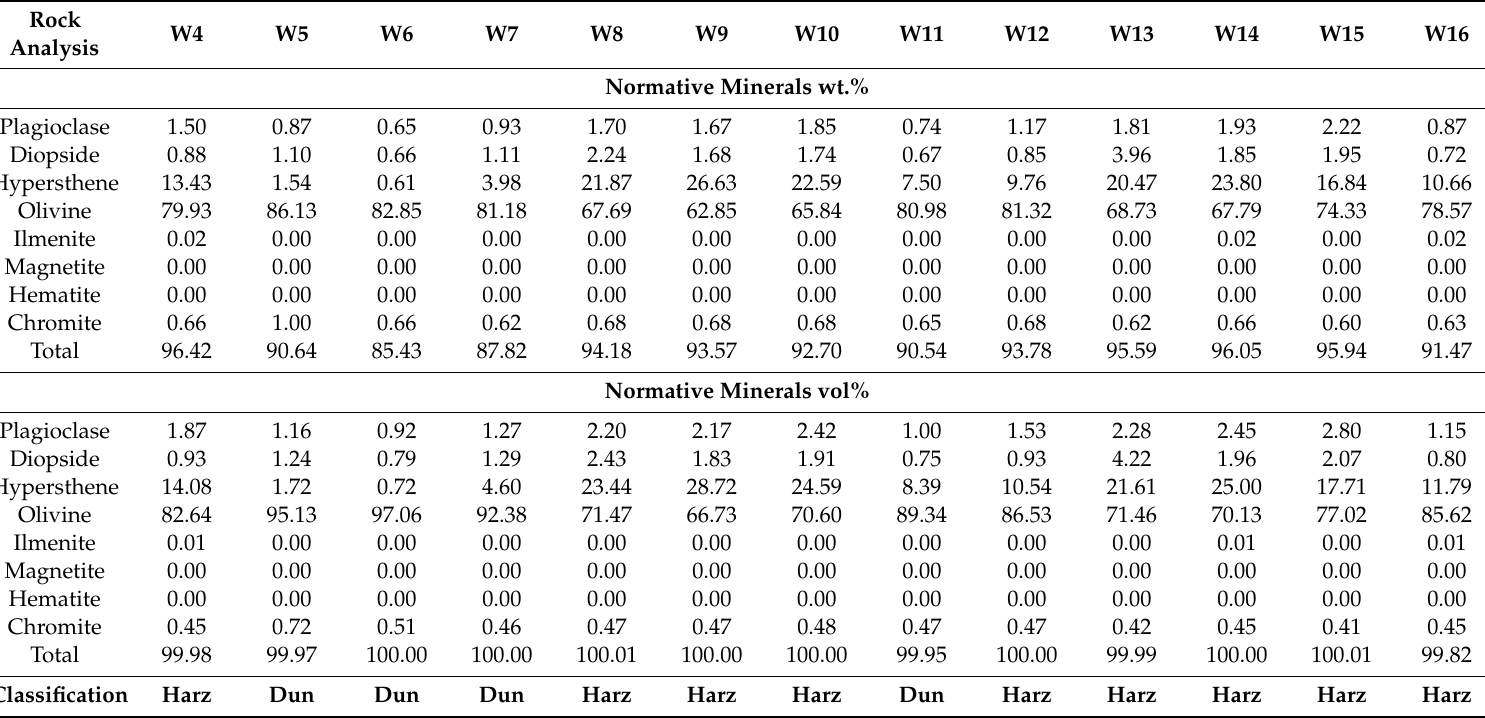
Table 3. Normative mineralogy recalculations (CIPW) of the serpentinized peridotites and the classification of the samples into dunites (Dun) and harzburgites (Harz).